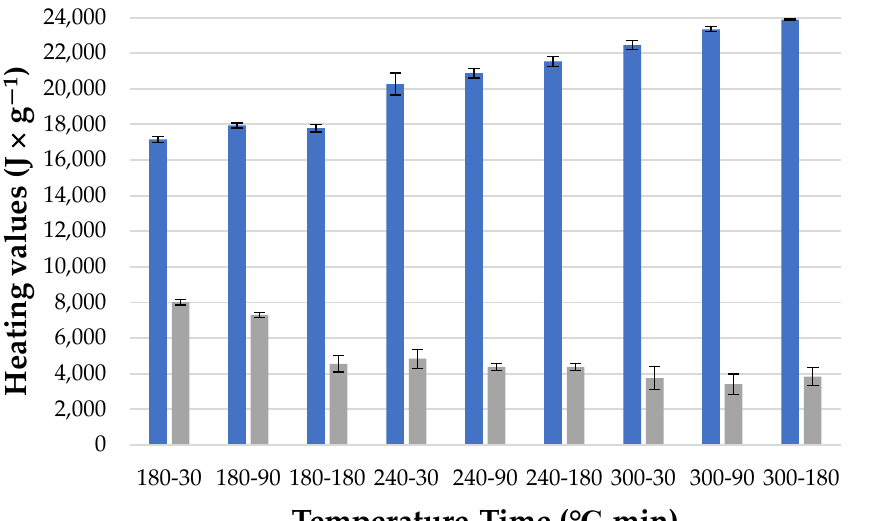
Figure 2. Van Krevelen’s diagram of raw and HTC treated chicken manure. An HHV refers to the highest possible energy that is released through the full oxidation process of one fuel unit [59]. As can be seen in Figure 3, the HHV of HC increased with the increase in both temperature and time.